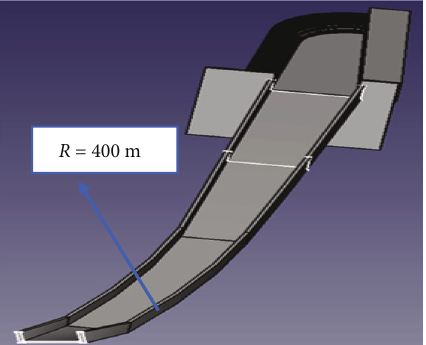
Figure 1: Side channel spillway with curved chute R = 400m .